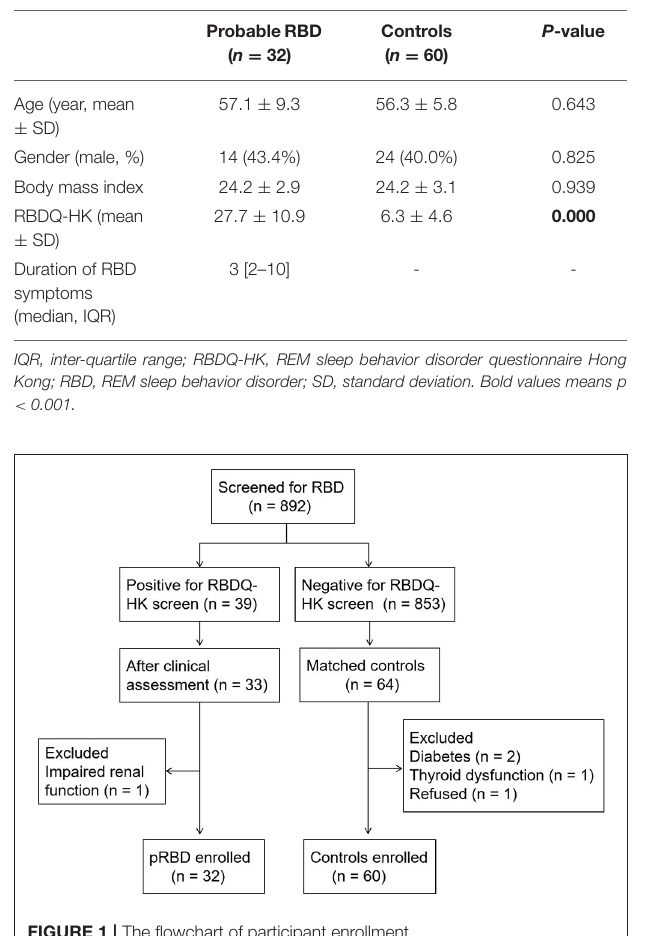
TABLE 1 | The demographic features of controls and participants with probable RBD.